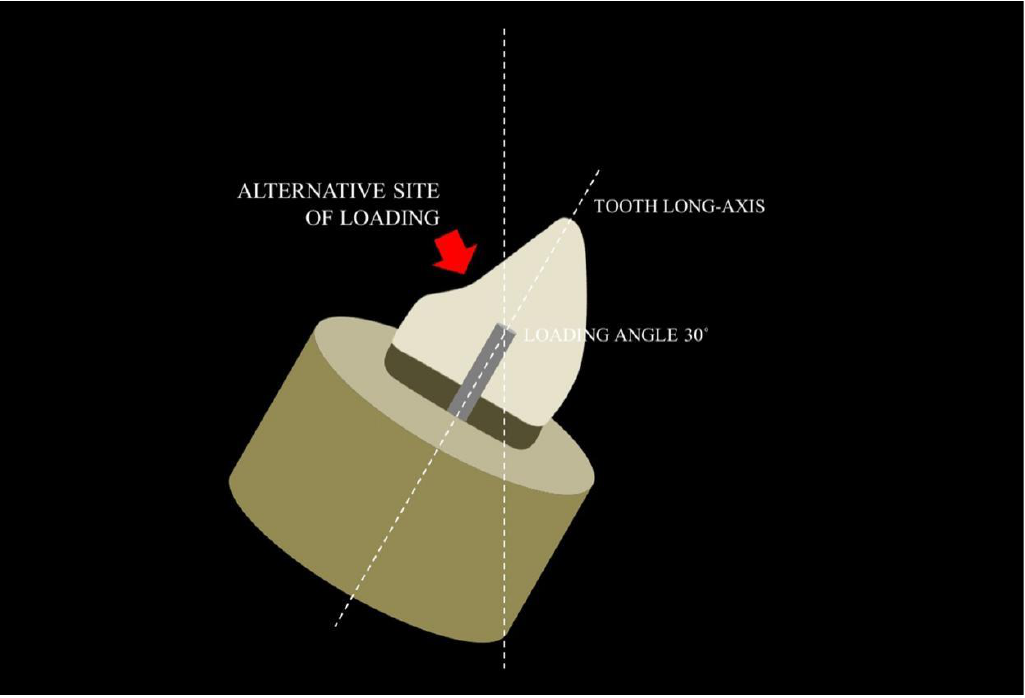
Figure 5. Expected fracture lines according to the loading angles with load applied on the alternative